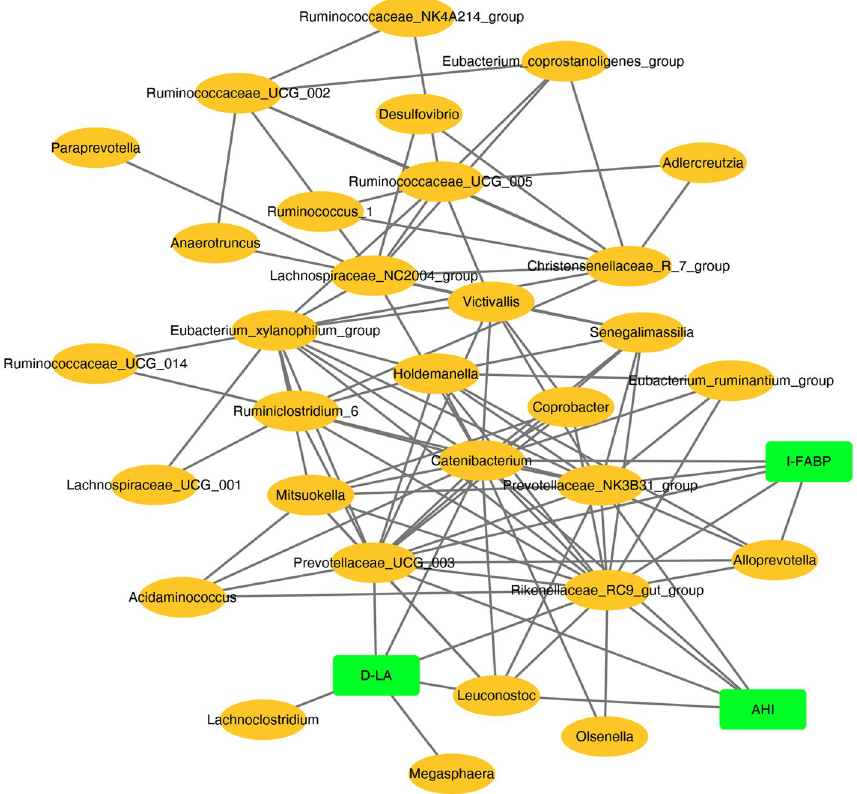
Figure 6. Network between taxa, AHI, and intestinal barrier biomarkers. SparCC was used to construct a genus taxa network. Positively related variables were kept in the network (The correlation coefficient between bacteria and clinical indicators was ≥ 0.4, and between bacteria and bacteria was ≥ 0.7). AHI, D-.LA, and I-FABP were associated with unique taxa. Streptobacillus, Prevotellaceae_UCG_003, and Rikenellaceae_RC9_gut_group were the common genera. Gut commensals co-occurred AHI and intestinal barrier biomarkers (D-LA and